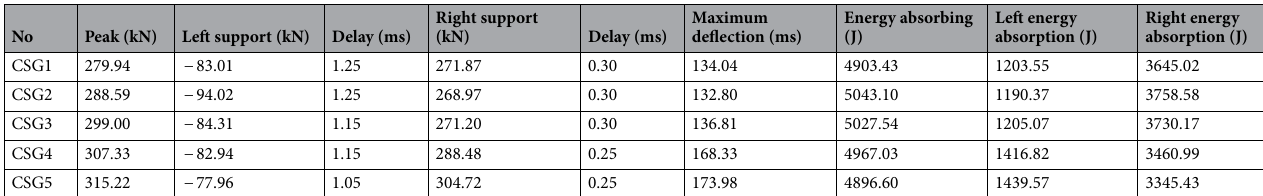
Table 7. Related data statistics of different concrete strength members. The downward direction of the impact force is positive, and the upward direction of the reaction force is positive.